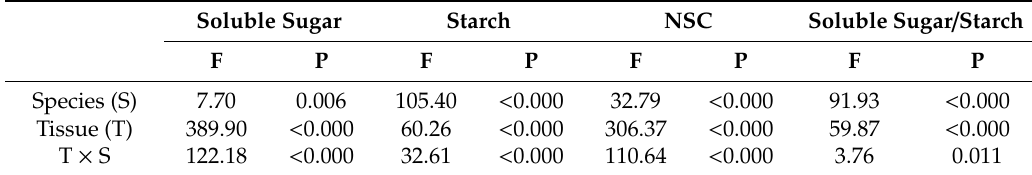
Table 1. E ff ects of tissue and species on the concentrations of non-structural carbohydrates (NSC), soluble sugar, starch and soluble sugars / starch, tested using a mixed e ff ects model. The treeline was used as a random variable to account for between-treeline variance. The significant levels of p < 0.05 are shown in bold.